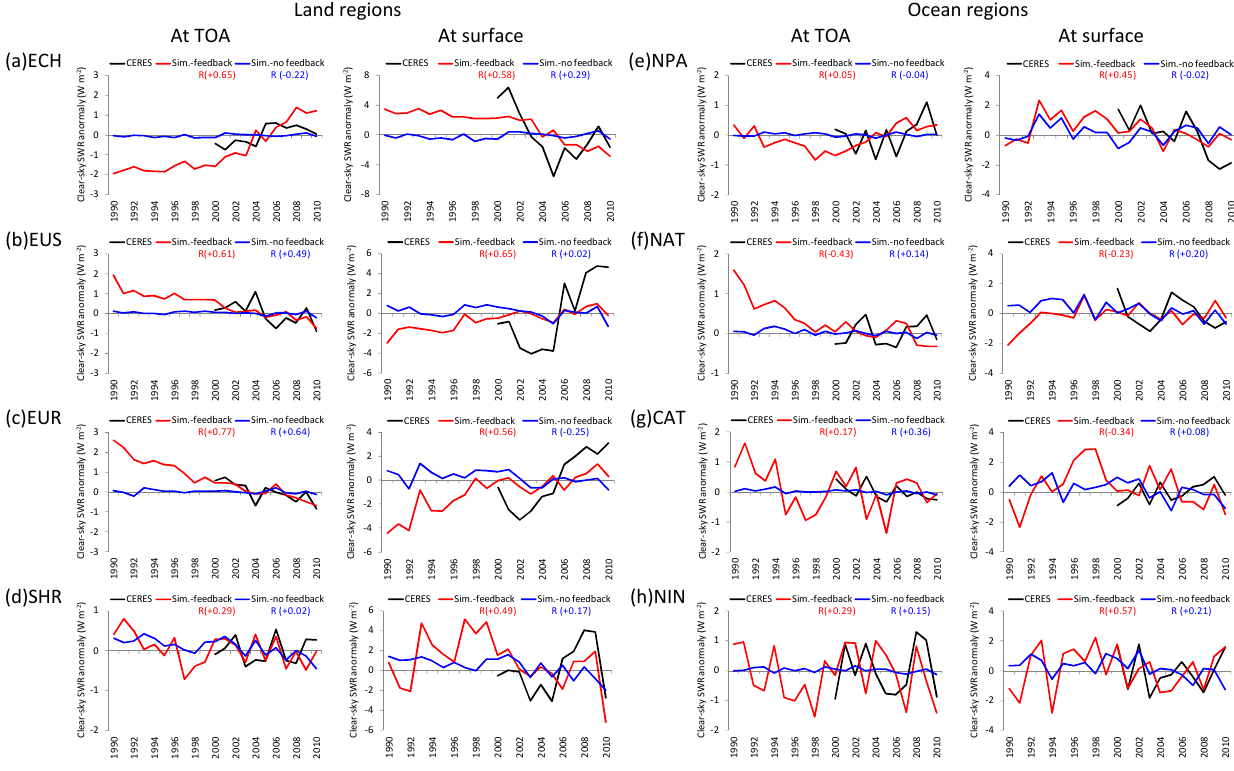
Figure 7. Observed and simulated time series of summertime clear-sky SWR at TOA and the surface (regional JJA average, anomaly in the average of 2000–2010; R is calculated from Sim.-feedback and Sim.-no feedback with